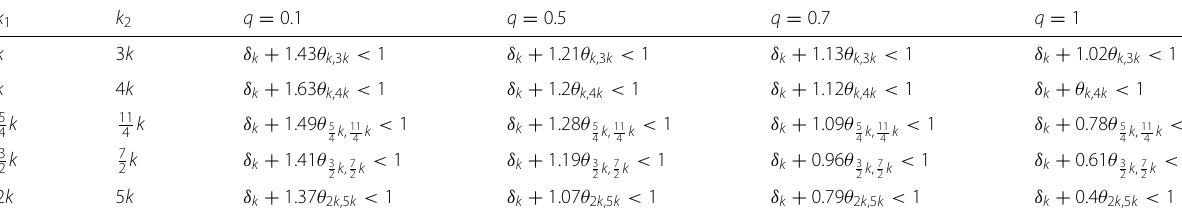
Table 1 Different sufficient conditions related to k 1 , k 2 , and